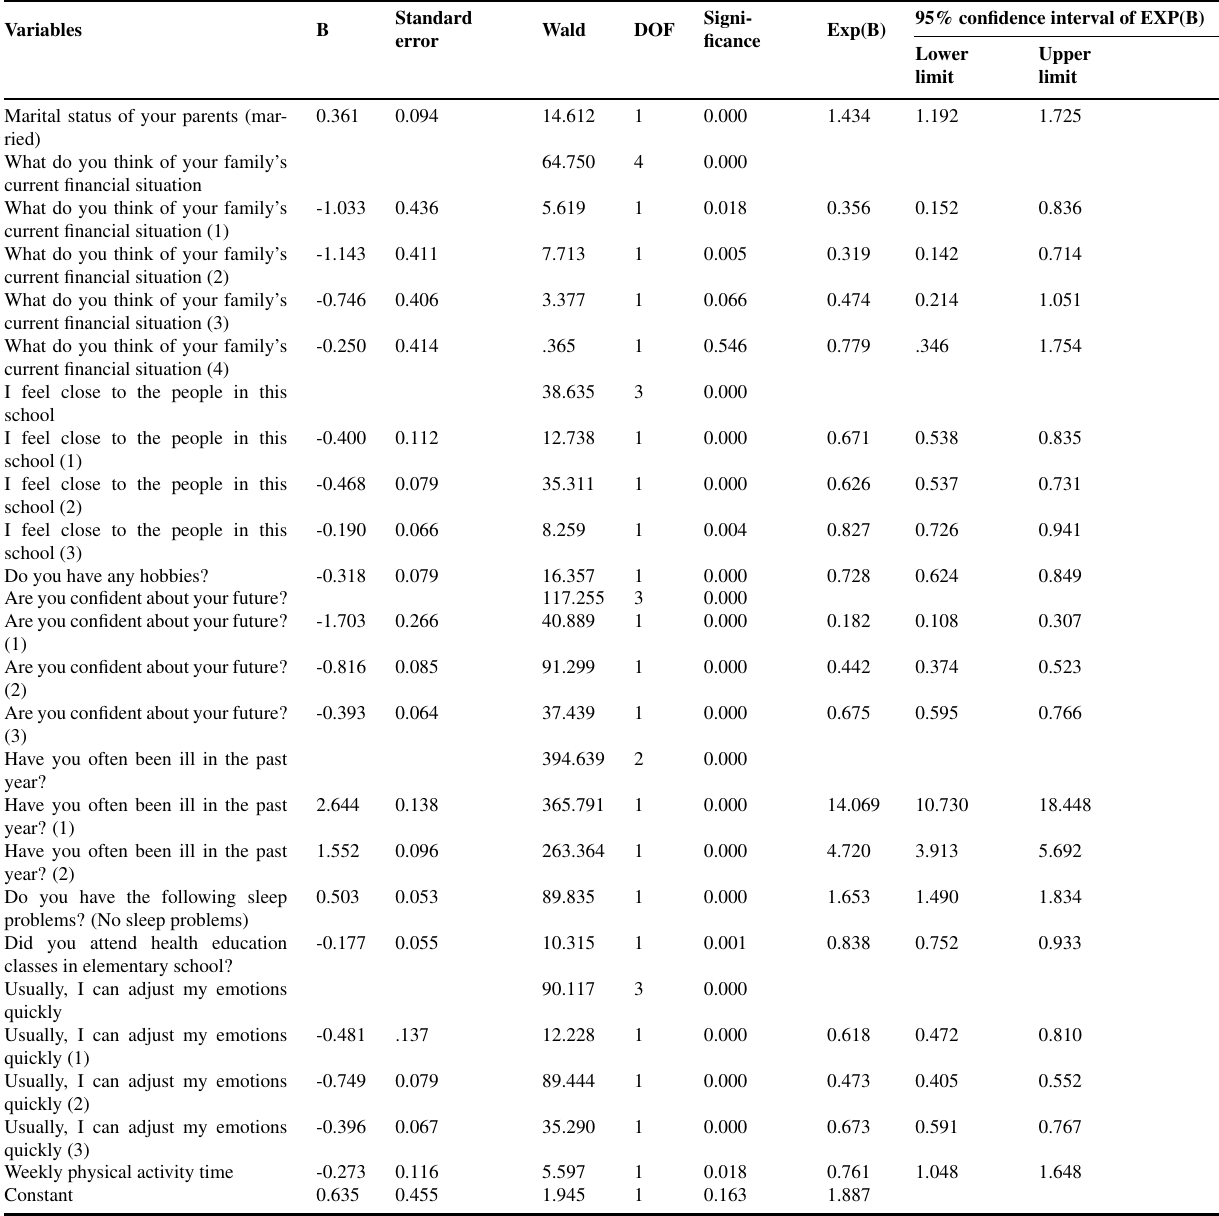
Table 5 Identification of the main factors affecting adolescent health and their